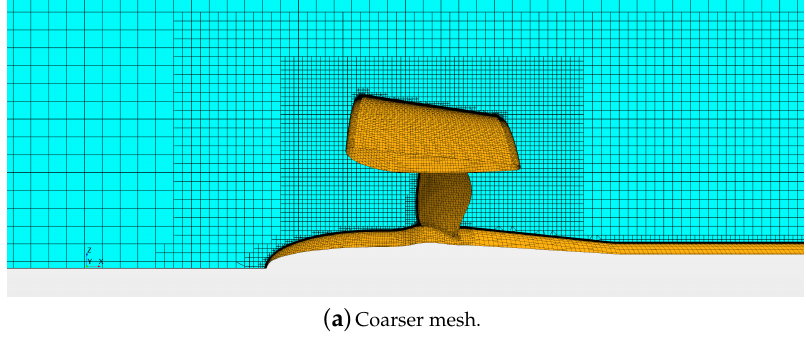
Figure 4. Open water tests for the decelerating ducted propeller: CFD (solid lines) vs. EFD (dashed lines).